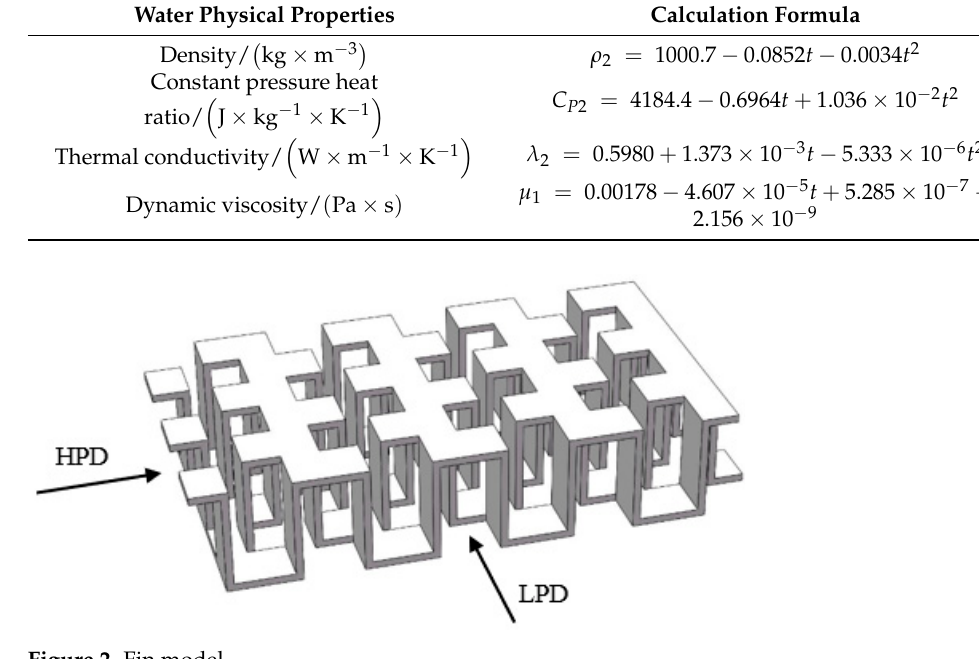
Figure 2. Fin model.